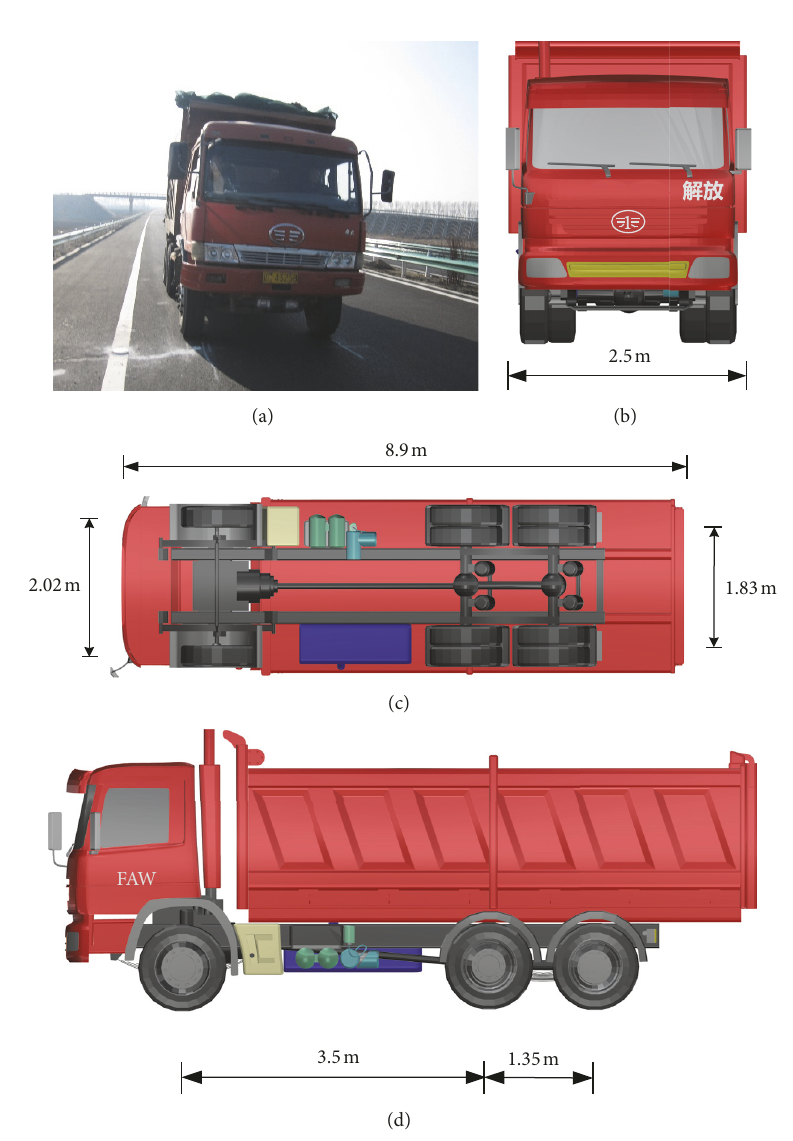
Figure 5: Dimensions of the test